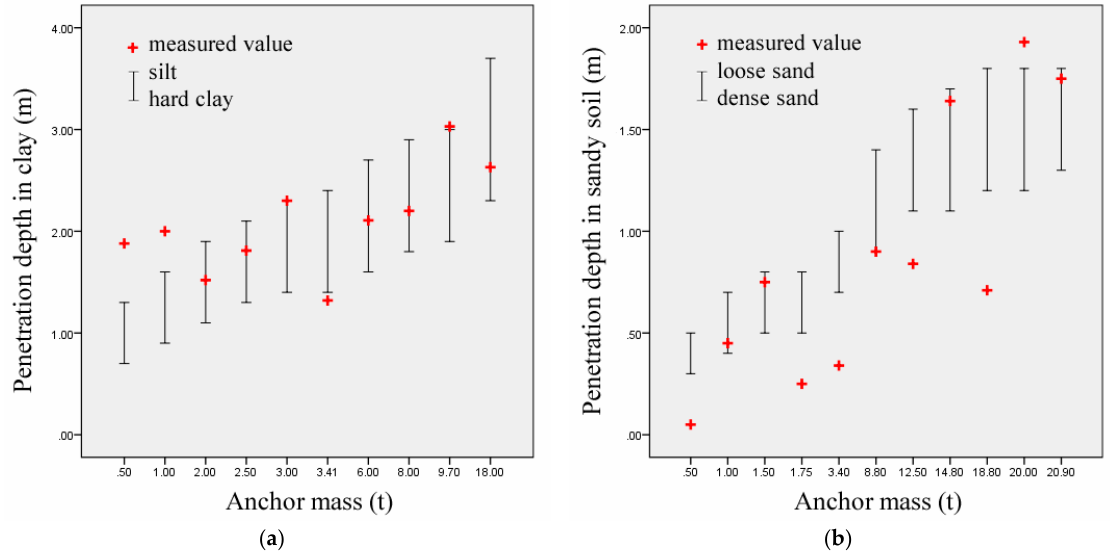
Figure 9. High–low graph of the penetration depth (( a ) in clay and ( b ) in sand